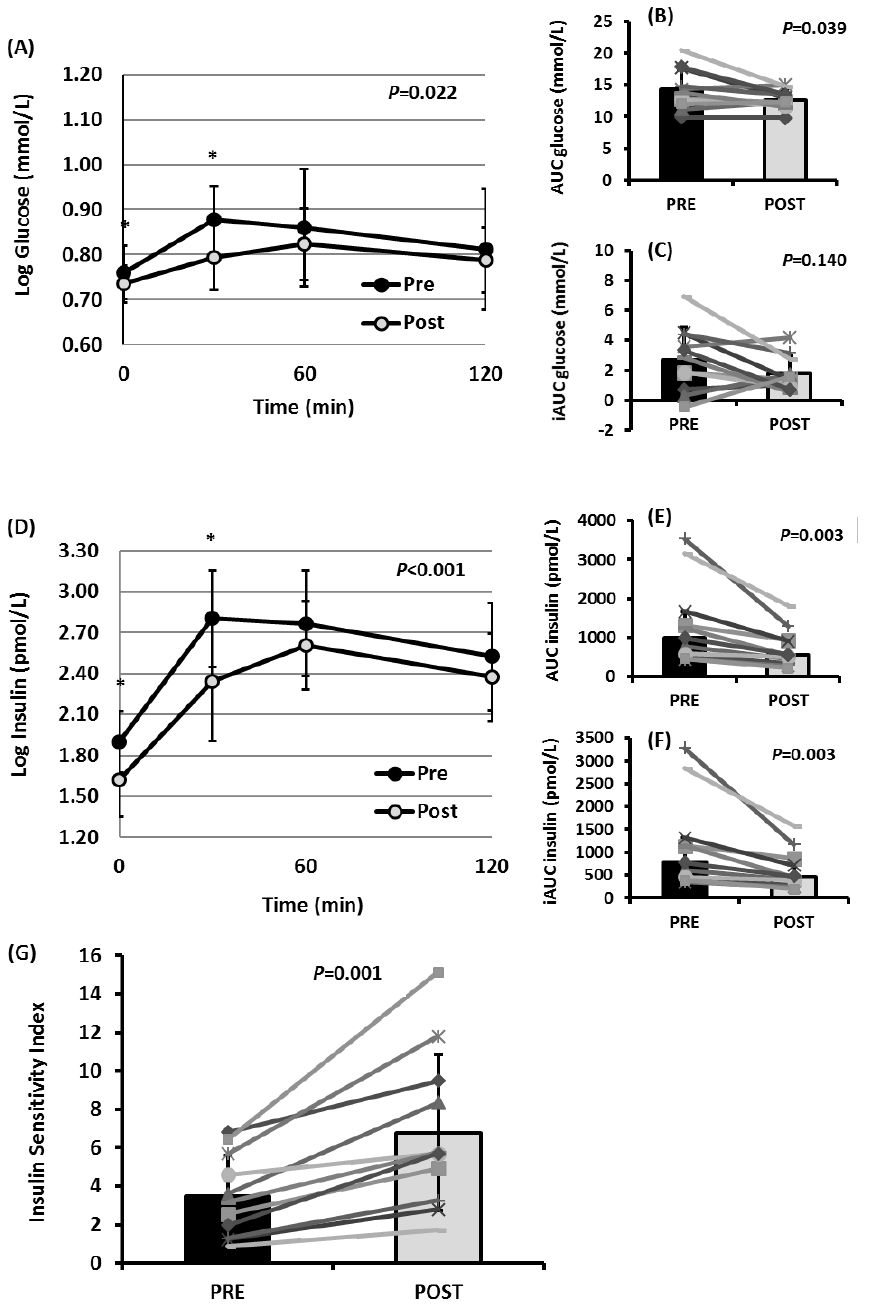
Figure 4. Mixed-meal tolerance test (MMTT) in overweight and obese participants before (pre) and after (post) the dietary intervention with the modified Mediterranean diet (n = 11). ( A ) Postprandial plasma glucose. ( B ) Total areas under the curve (AUCs) for glucose. ( C ) Incremental areas under the concentration-versus-time curves (above fasting values, iAUCs) for glucose. ( D ) Postprandial serum insulin. ( E ) AUCs for insulin. ( F ) iAUCs for insulin. ( G ) Postprandial ISI. p -values were derived from paired t -tests or Wilcoxon rank tests or ANOVA for repeated measures. Statistical significance was set at the 5% level. ANOVA, analysis of variance; ISI, insulin sensitivity index. * p < 0.05 according to posthoc Bonferroni comparisons.